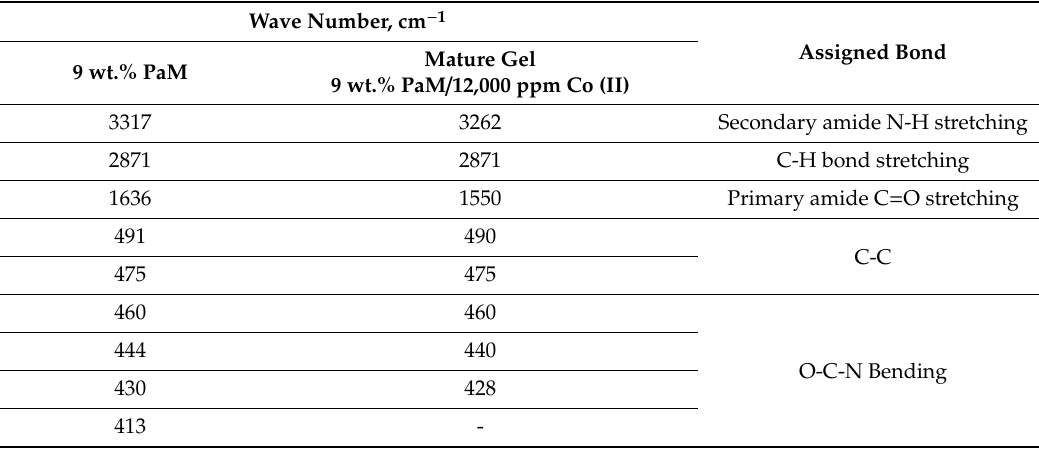
Figure 9. Fourier-transform infrared spectroscopy (FTIR) of 9 wt.% PAM and 9 wt.% PAM/12,000 ppm Co (II) mature gel. Table 3. Functional group analysis using FTIR.